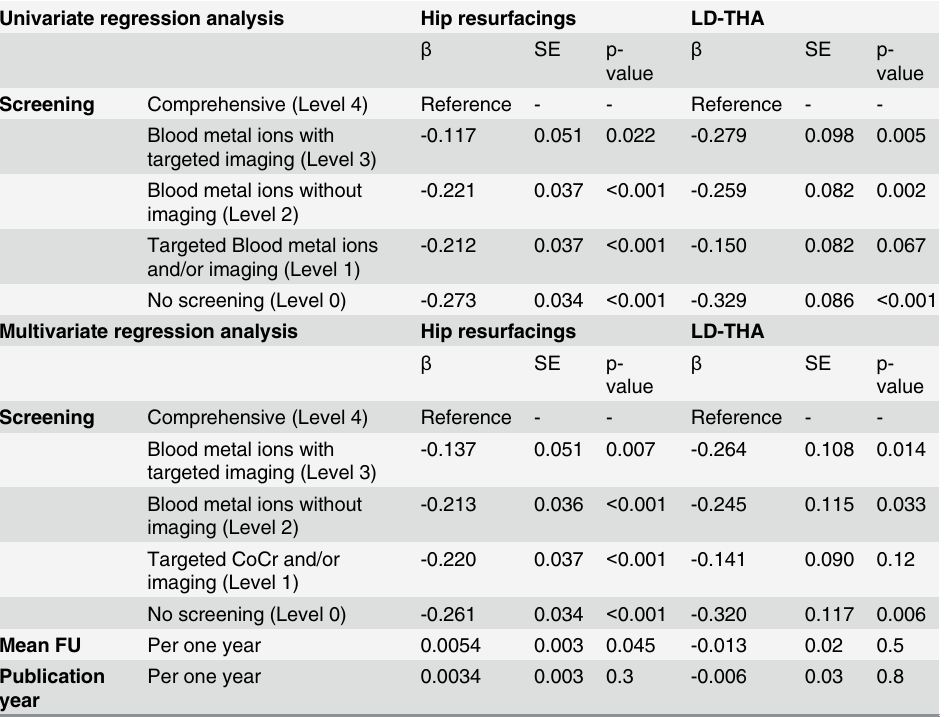
Table 3. Results of the metaregression analysis in the HR and LD THR